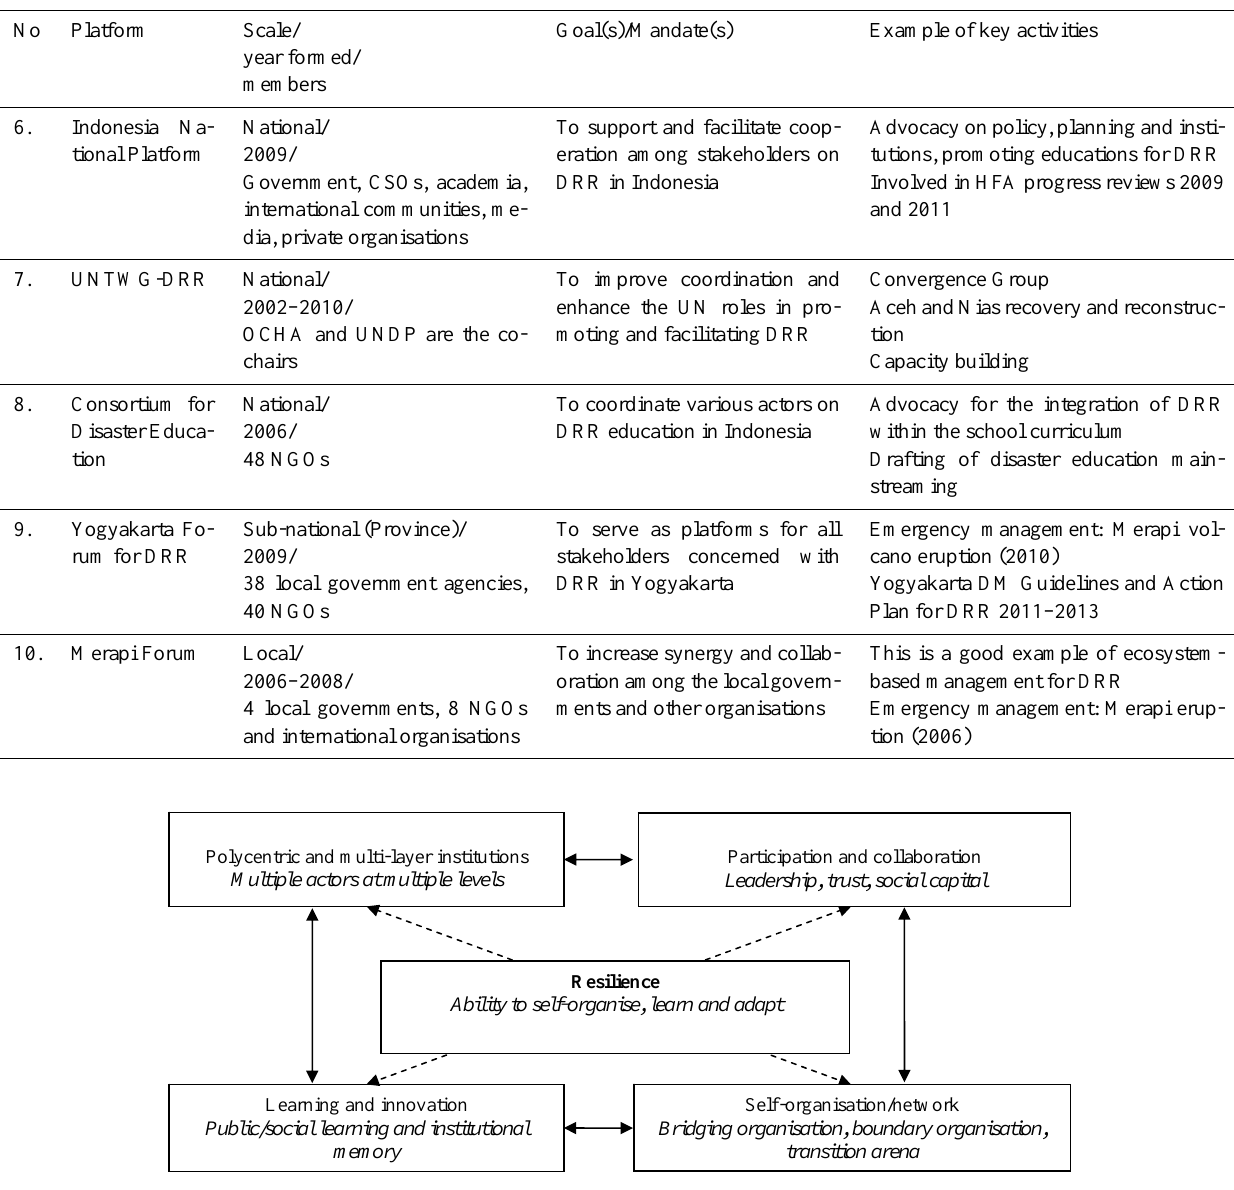
1 Solid line arrows represent the main relationships, while the dashed lines represent the indirect relationships between the char-